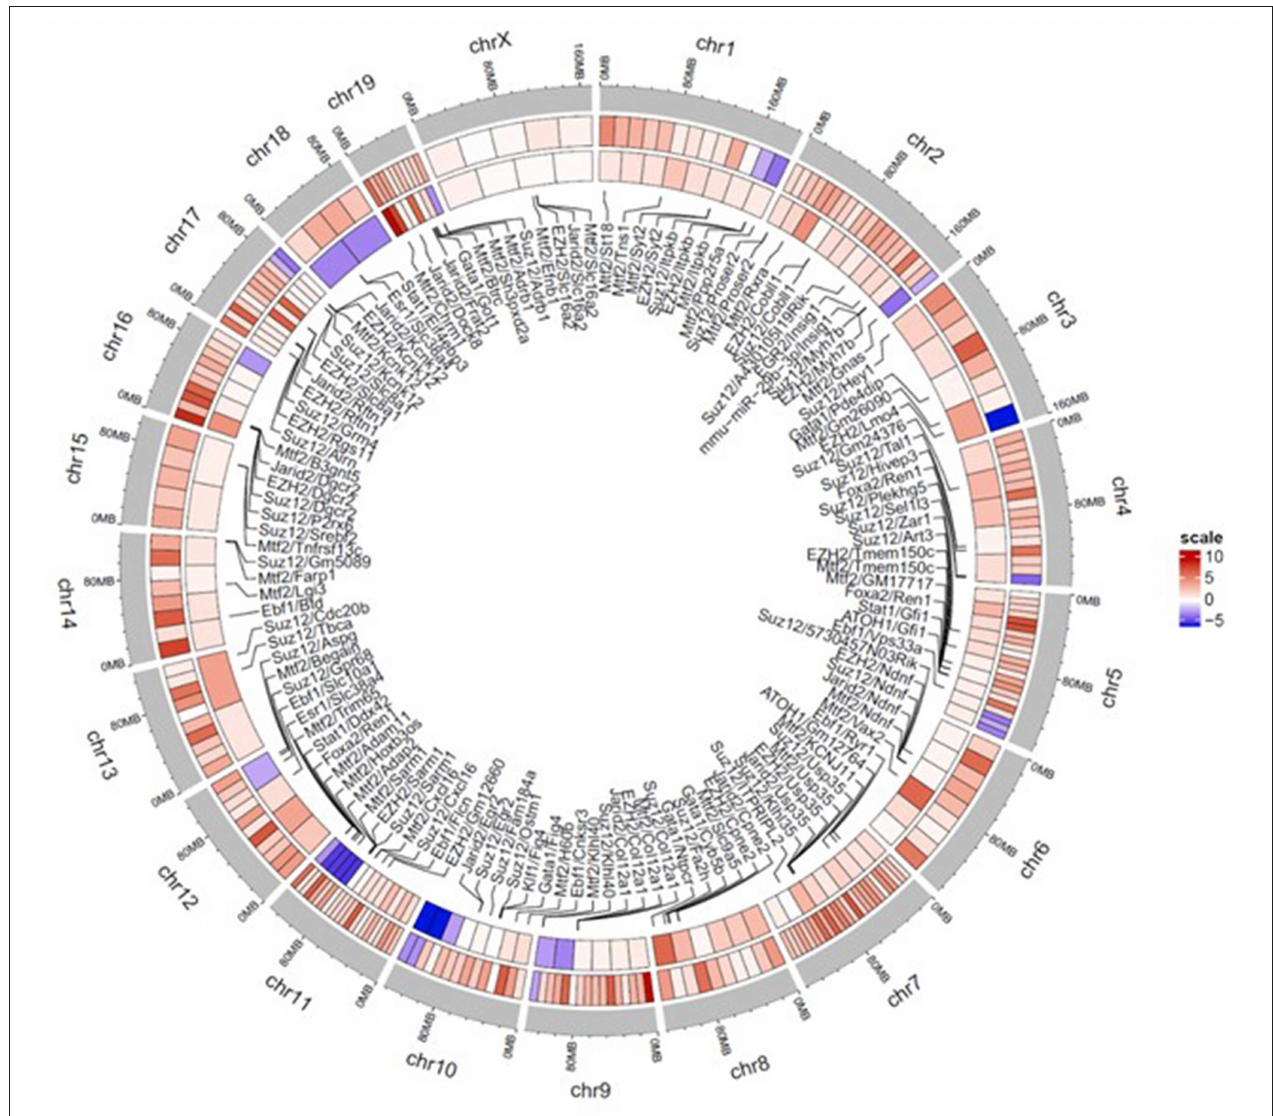
FIGURE 6 | Circos plot heatmap showing gene promoter and regulatory element regions that were significantly hyper or hypo-methylated with continuous TCE exposure. The heatmap indicates the average Log 2 fold change values for the statistically significant DMRs of promoters (outer ring) and regulatory elements (innermost ring). The outer most ring (gray) shows the chromosome and location. The lines point to associated regulatory element and chromosome location. Red indicates hypermethylation and blue indicates hypomethylation relative to